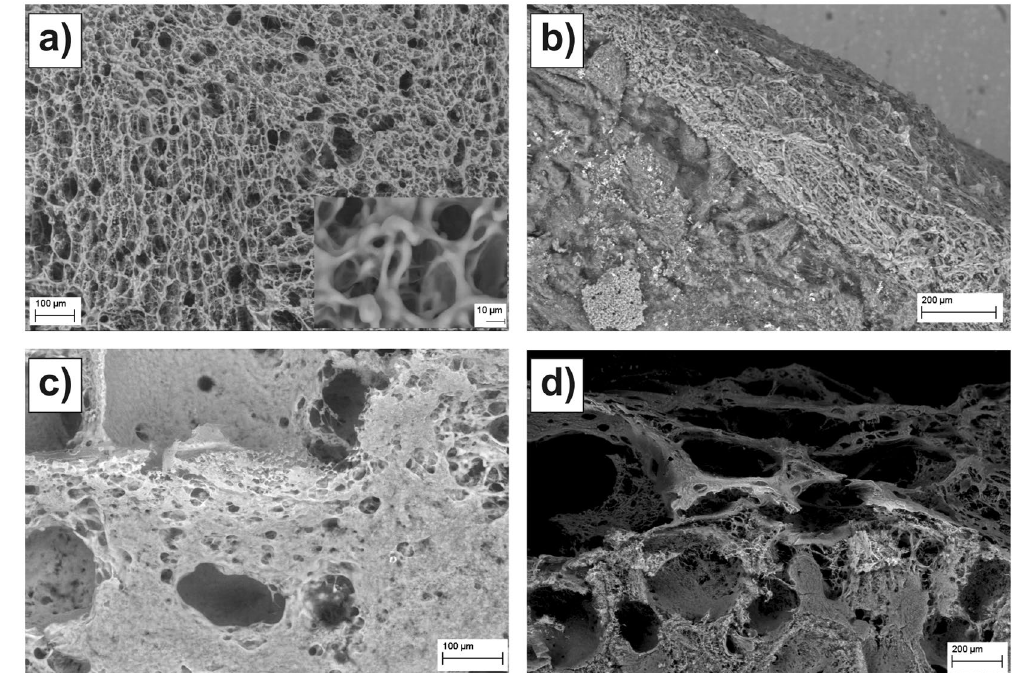
Figure 1. SEM images of ileum mucosa. ( a) Top and ( b) section images of ileum samples exposed to PBS pH 7.4 for 30 min. The inset in ( a ) shows the same sample at a higher magnification. ( c) Top and ( d) section images of ileum samples subsequently exposed to PBS pH 2 for 30 min.